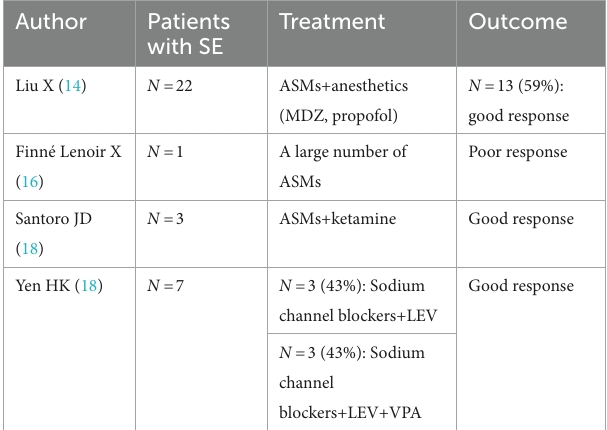
TABLE 3 Use of ASMs in SE or refractory SE in anti-NMDAR